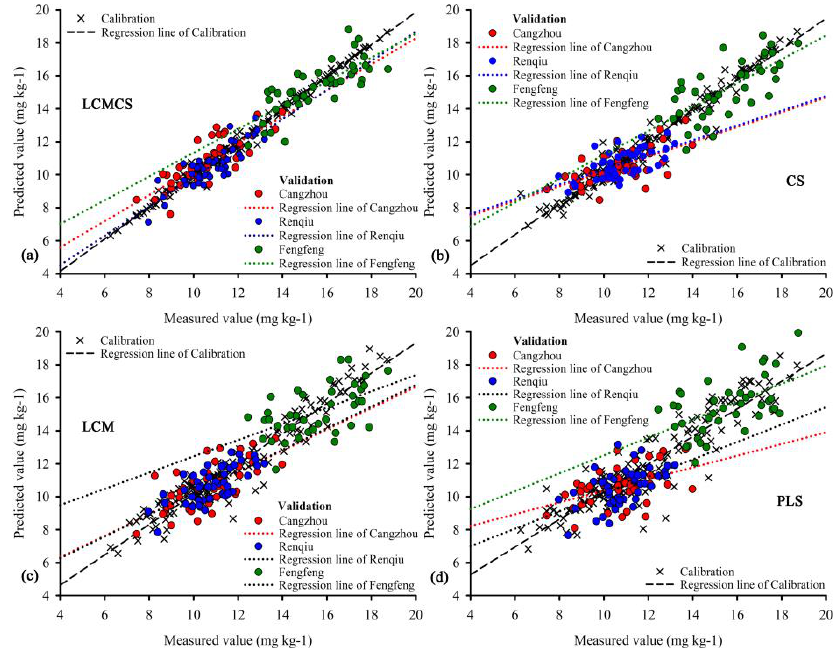
Figure 7. Comparisons of measured and predicted values by the local correlation maximization-complementary superiority method (LCMCS) (a), complementary superiority (CS) (b), local correlation maximization (LCM) (c) and partial least squares regression (PLS) (d)